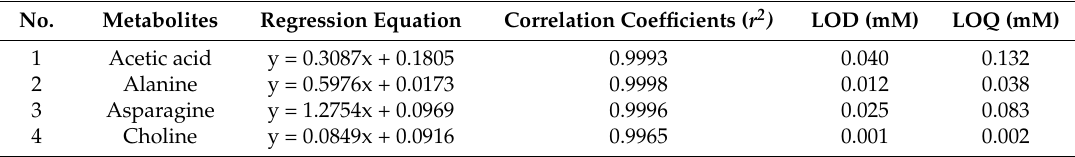
Table 2. The linear regression equations, LOD and LOQ for 11 metabolites ( n =